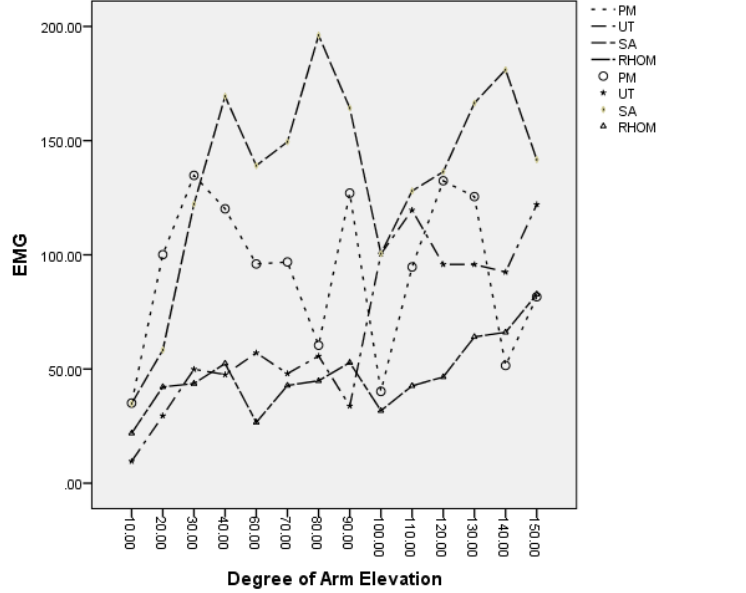
Figure 2. Typical observations from a patient’s arm movement.